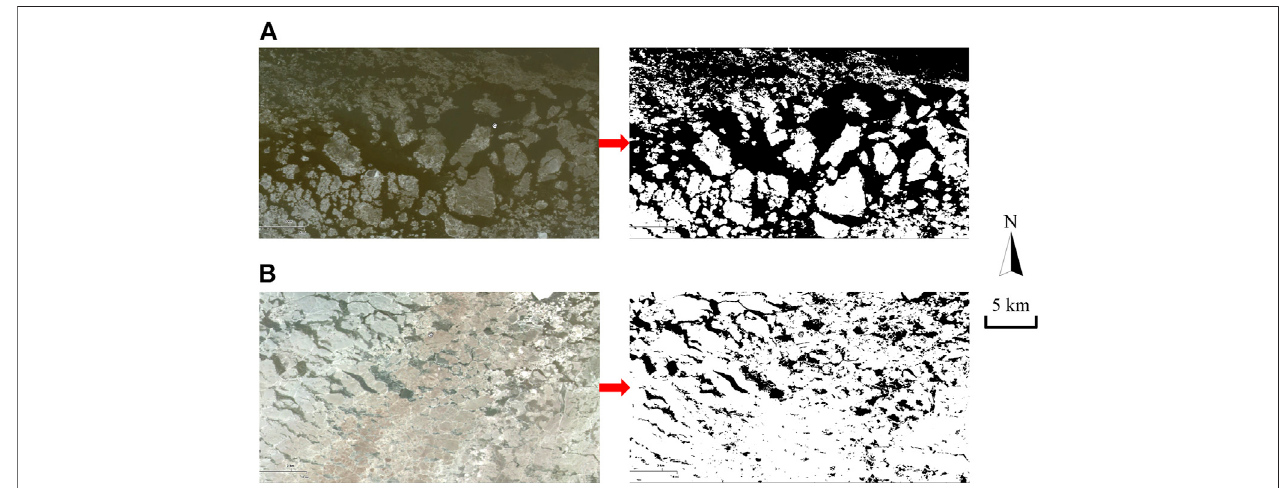
FIGURE 4 | Examples of transformations from satellite images at (A) site 22 on 2 February and (B) site 6 on 1 February 2016 to black – white binary copies after thresholding segmentation. In binary copies, white represents ice and black represents water. Also shown are the scale and north arrow of the images.